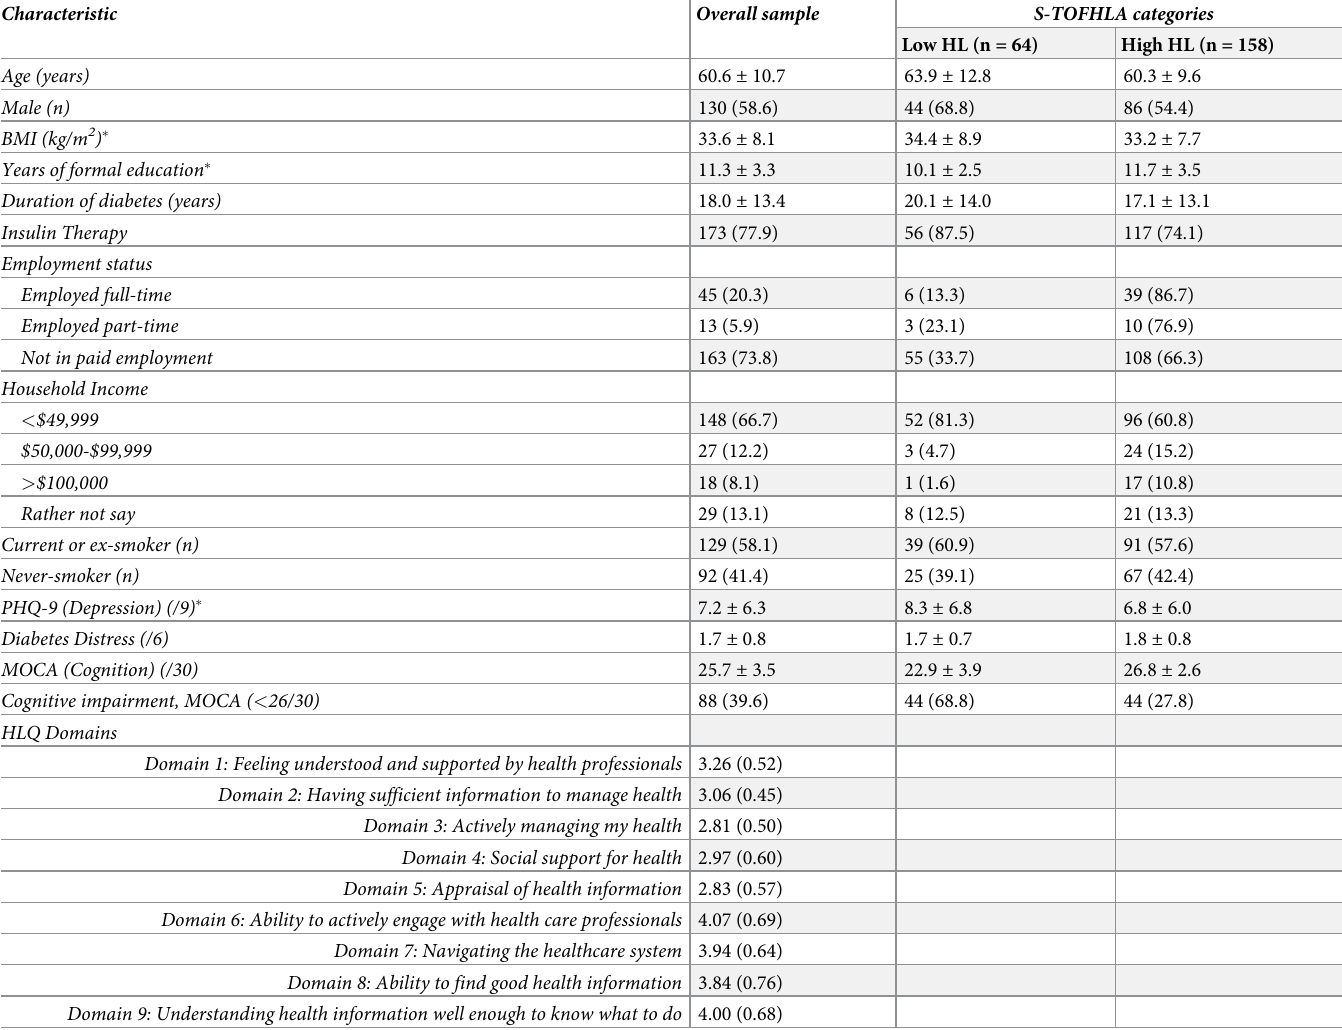
Table 1. Demographic data for participants of the SHELLED